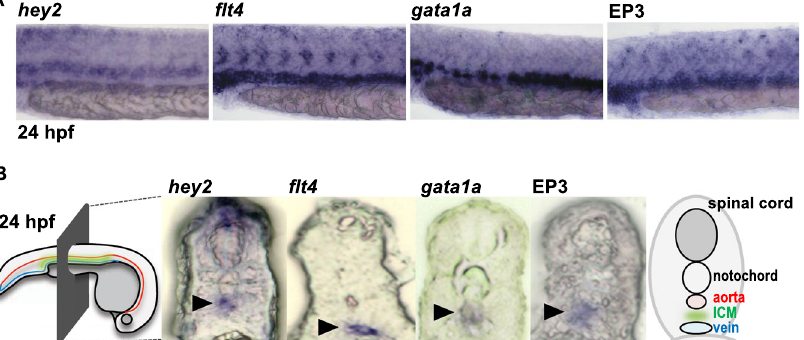
Figure 4. EP3 receptor mRNA is expressed in the posterior cardinal vein and the neighboring ICM. ( A , B ) Regions of expression of marker genes and the EP3 receptor were analyzed by WISH at 24 hpf ( A ) and subsequently by microscopic examination of their cross-sections ( B ). Arrowheads indicate the regions where the signals derived from each gene were